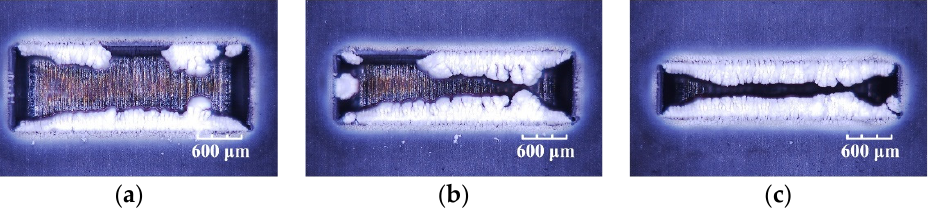
Figure 8. Workpieces of different widths processed by conventional laser processing, shown after ultrasonic cleaning: ( a ) width of 1 mm, ( b ) width of 0.8 mm, ( c ) width of 0.6 mm.